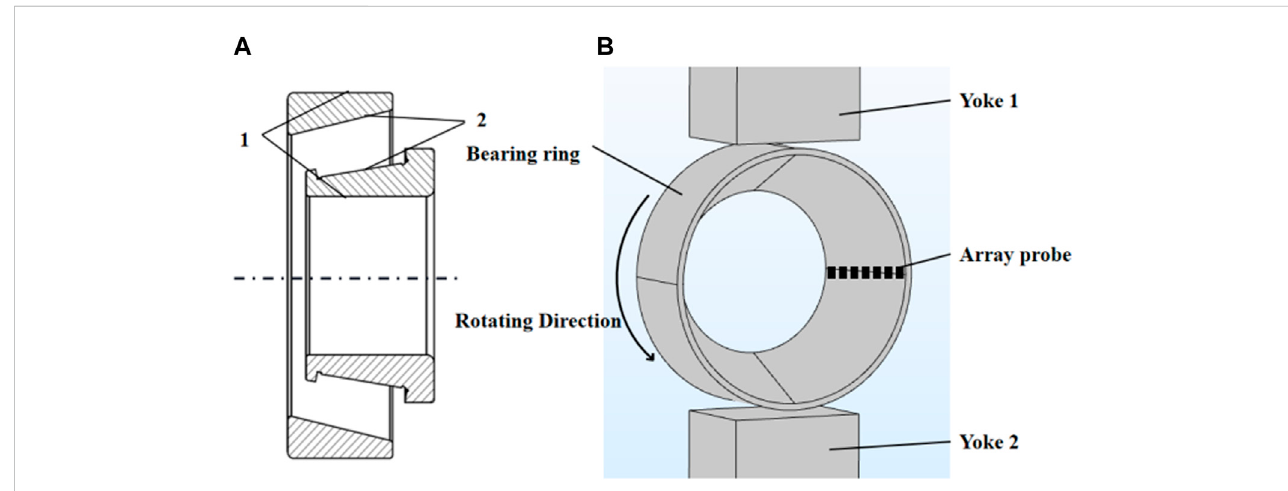
FIGURE 1 (A) Schematic diagram of the bearing sleeve ring structure; (B) Schematic diagram of peripheral magnetization of the bearing